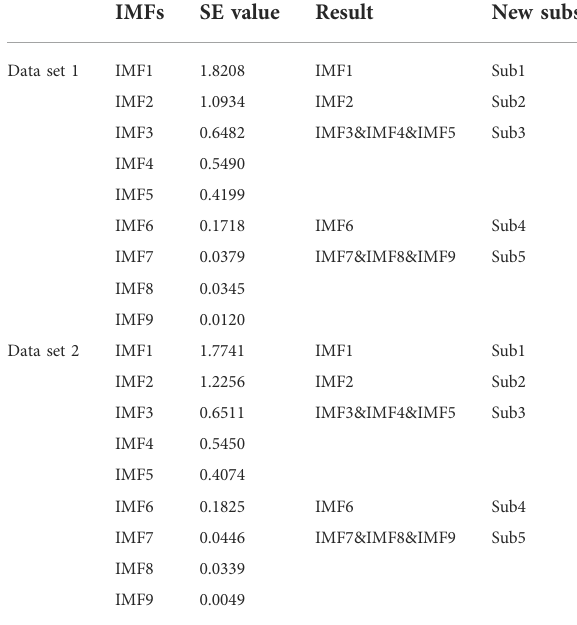
TABLE 3 Key parameter setting for each model. Model